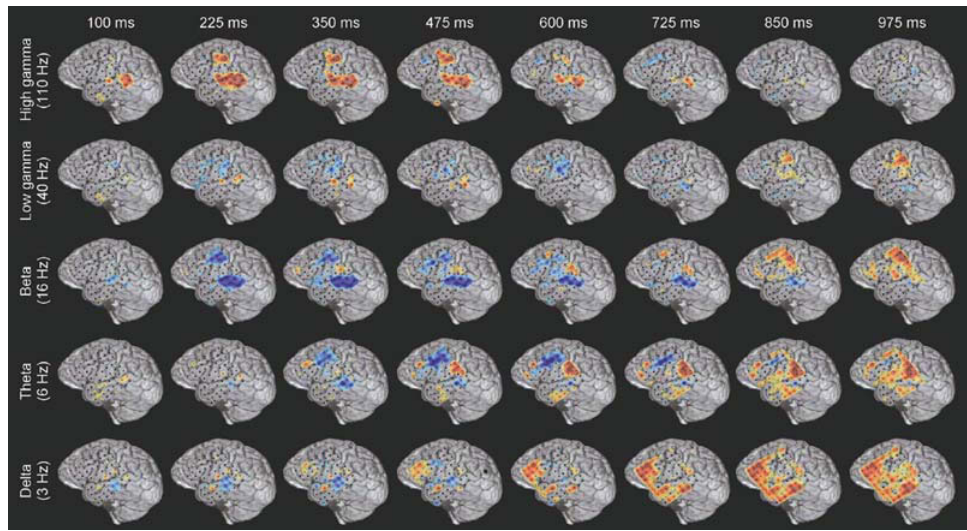
Figure3. Example of the spatiotemporally complex oscillatory dynamics associated with verb processing. Spatial pattern of power changes in different frequency bands at successive times in response to verb presentation in subject A (see Figure 4A for electrode locations on MRI rendering and methods for MNI coordinates). Red indicates power increase and blue indicates power decrease. HG activity along the STG and STS has an early, strong onset, and in this subject is accompanied by activation of premotor regions. An initial beta power decrease occurs at and surrounding regions of strong HG activity, but note the late (850–975ms) beta power increase over motor areas. Theta power shows a transient power decrease over premotor/frontal areas (350–725ms) and a late onset power increase over the inferior parietal lobule (e.g., 600–975ms). Delta activity is late and spatially diffuse over prefrontal and middle temporal regions. Note that power changes in different frequency bands are active in overlapping but distinct cortical territories, and show distinct temporal patterns of onset, duration, and